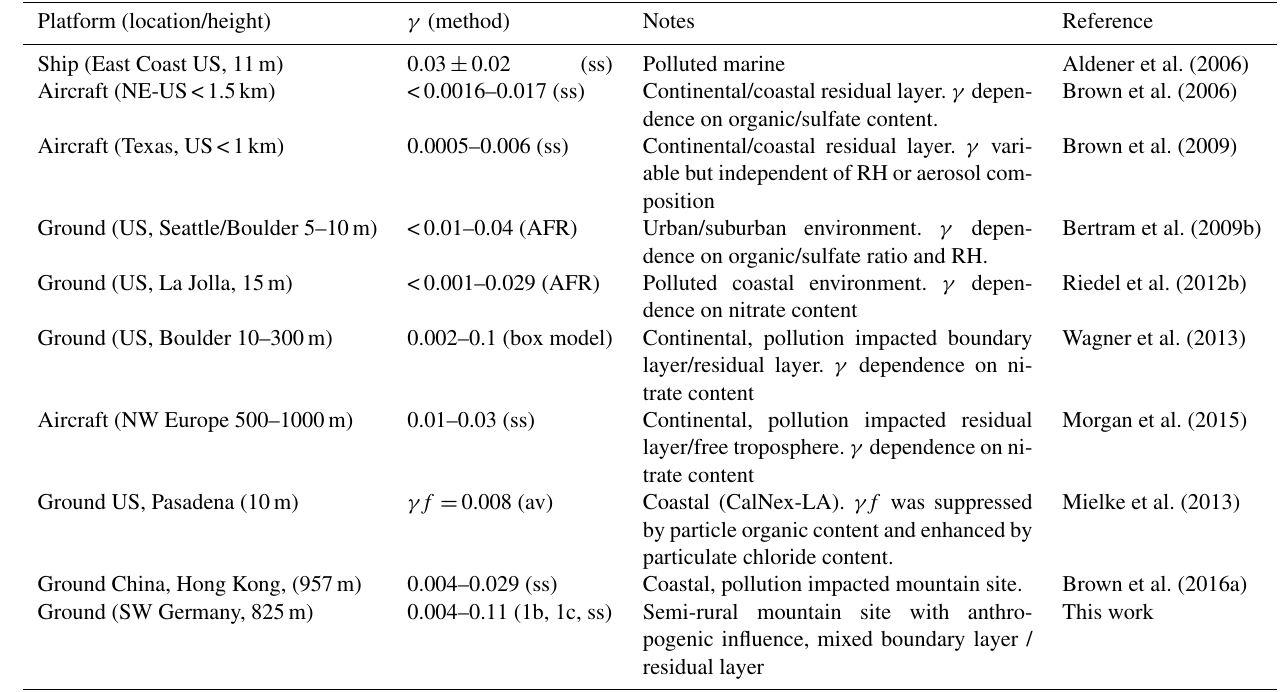
Table 1. Values of γ derived from ambient